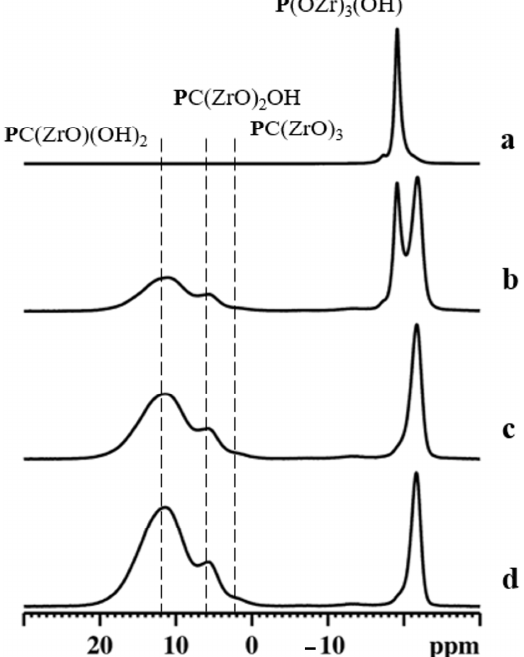
Figure 8. 31 P MAS NMR spectra of α ZP (a), α ZP05 (b), α ZP1 (c), and α ZP2 (d). A MAS rate of 15 kHz was employed during the experiments.